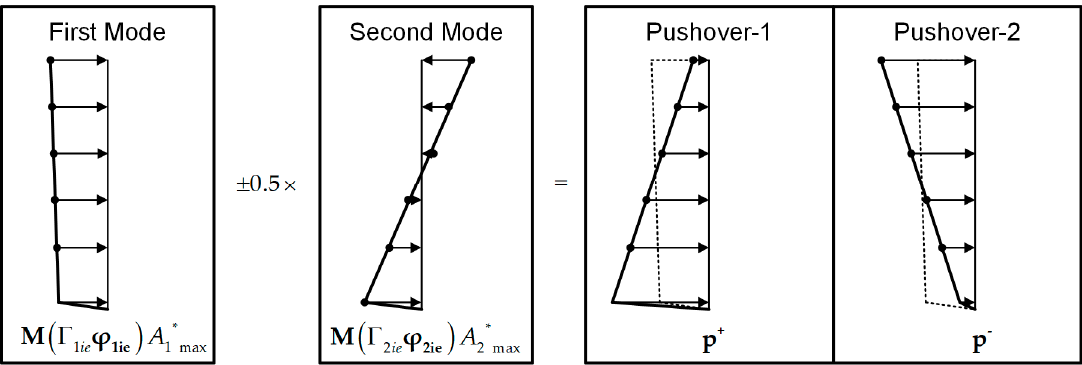
Figure 2. Concept of horizontal force distribution obtained from combination of two modal responses.